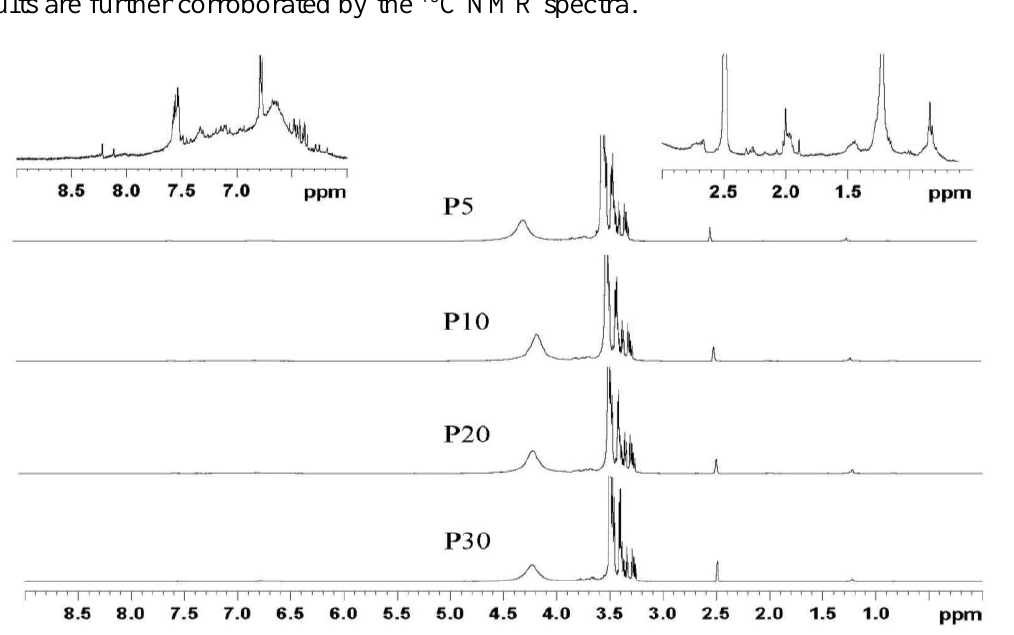
Figure 2. 1 H NMR spectra of all the liquefied